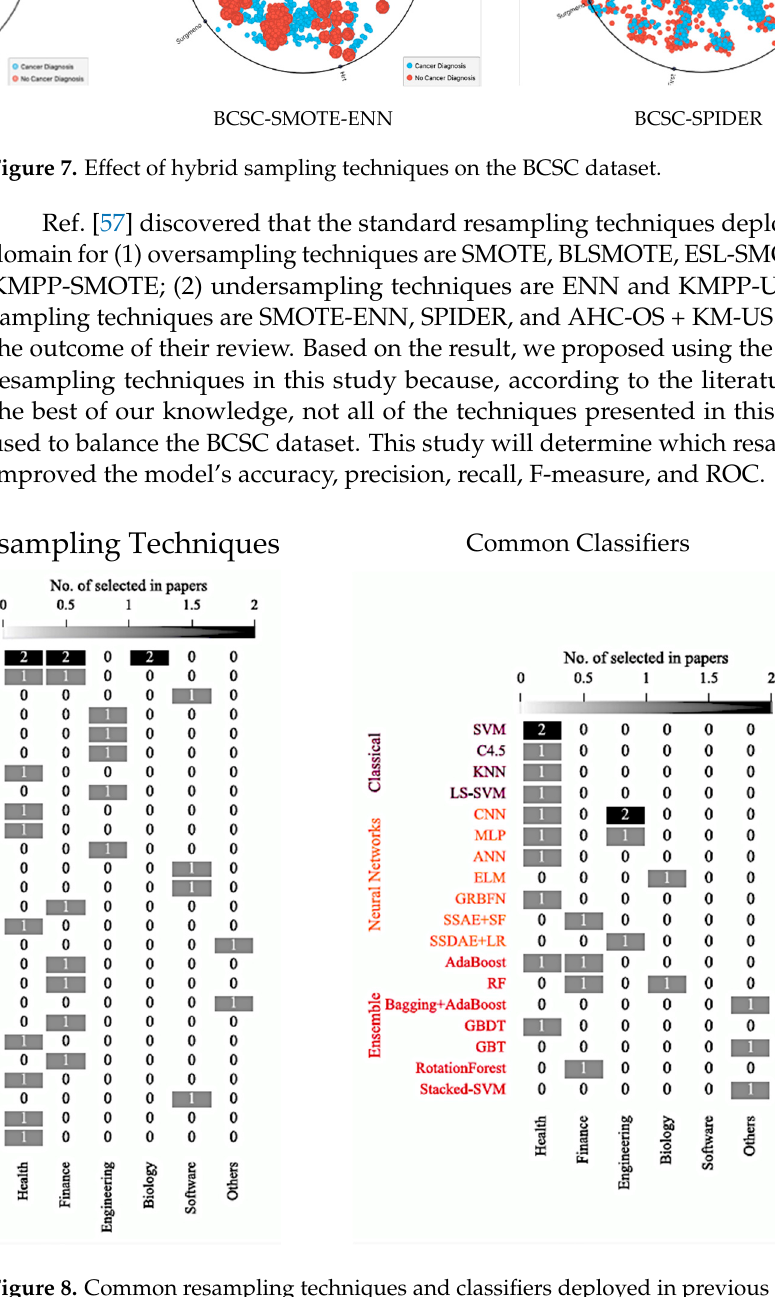
Figure 7. Effect of hybrid sampling techniques on the BCSC dataset.